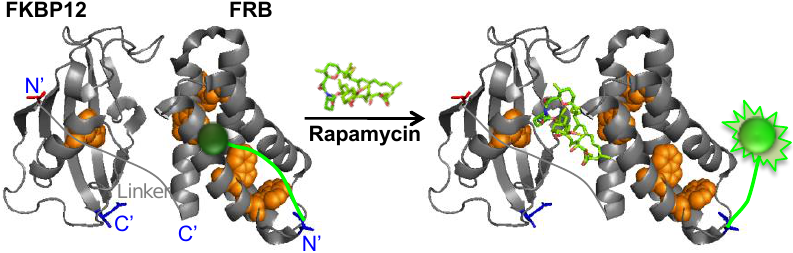
Figure 1. Scheme of rapamycin quenchbody (Q’-body) (based on protein data bank entry 1fap [6]).